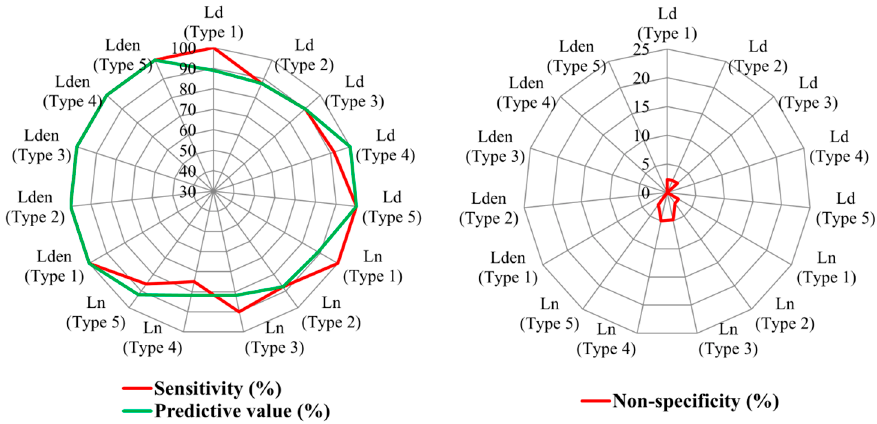
Figure 6. Results of ROC analysis for the different sound descriptors registered in the road categories.